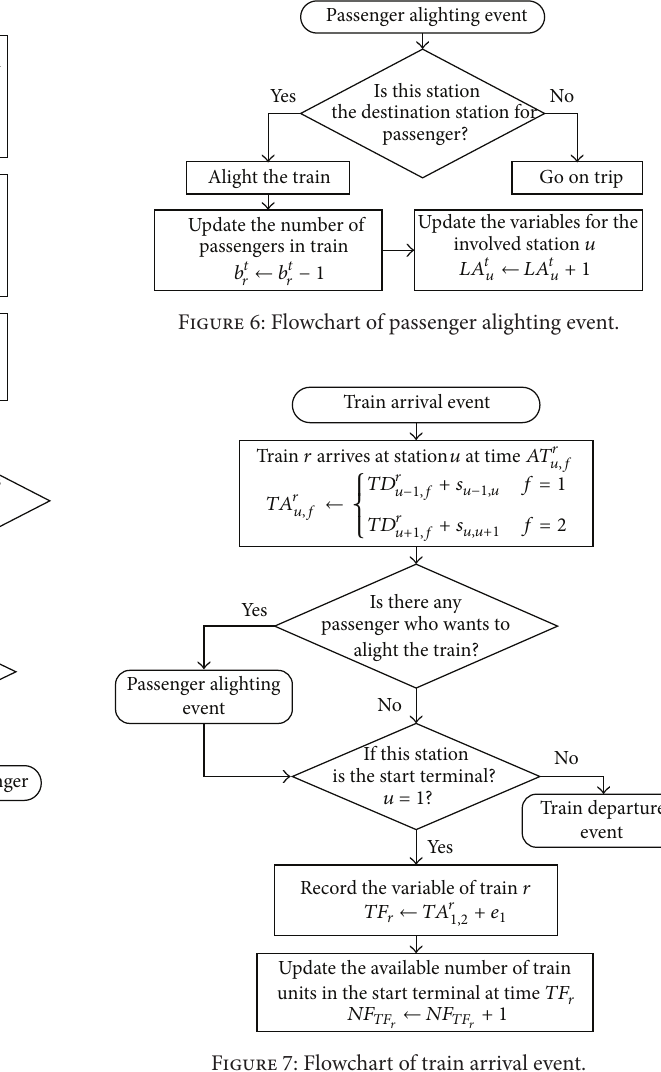
Figure 7: Flowchart of train arrival